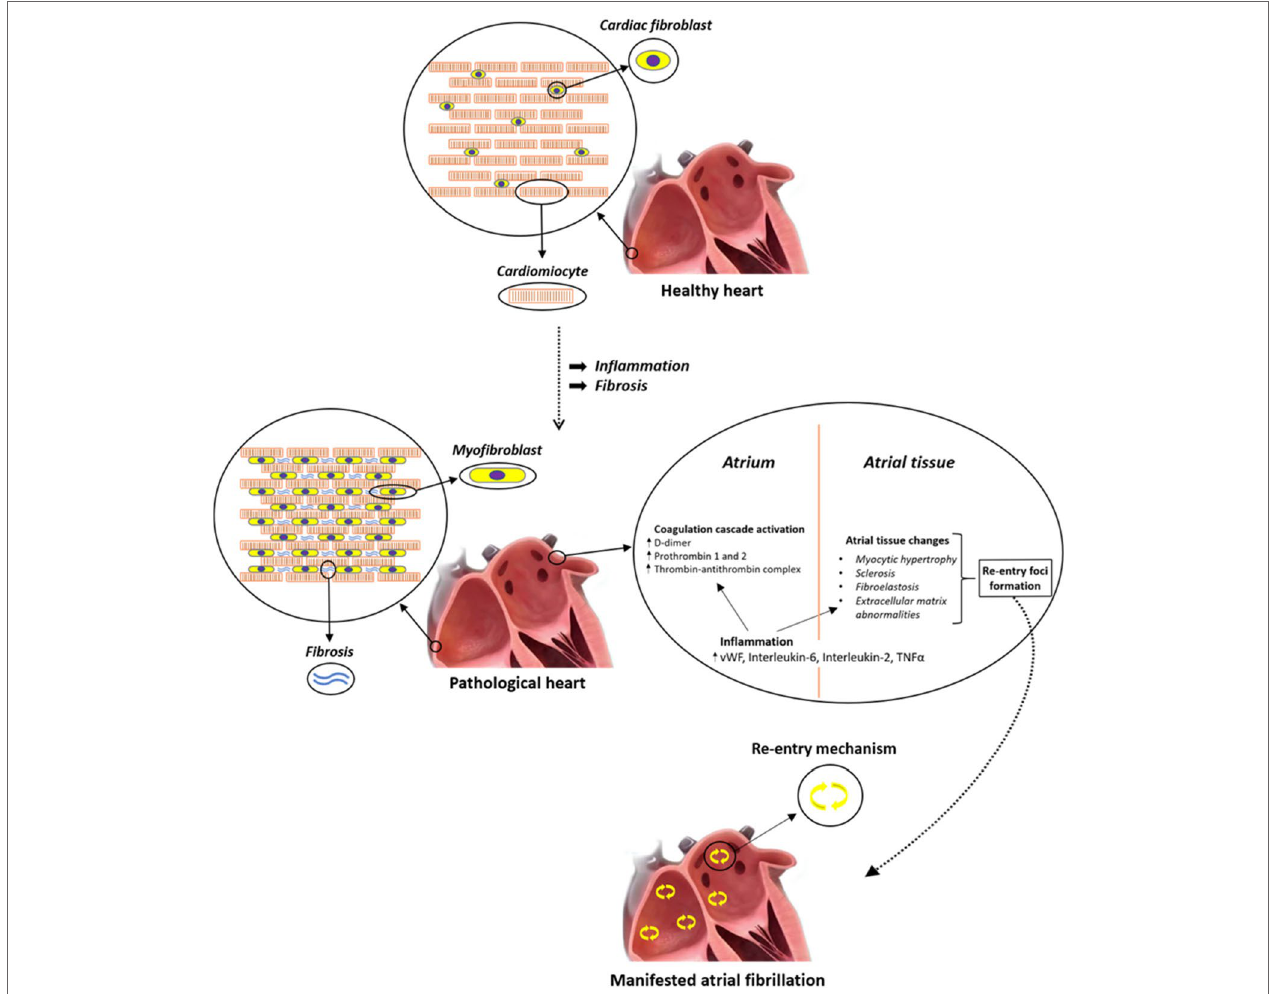
FIGURe 1 | Systemic inflammation correlates with an increased risk of atrial fibrillation (AF) and thrombogenesis. Different inflammatory mediators, such as interleukin (IL)-2 and tumor necrosis factor alpha (TNFα), affect calcium handling and cause arrhythmogenic changes in atrial cardiomyocytes. In particular, altered TNFα-mediated Ca2+ handling could lead to arrhythmias due to calcium waves and delayed after-depolarization, which may generate premature APs and give birth to spontaneous beats that can then perpetuate themselves through re-entry mechanism. In addition, circulating cytokines can also stimulate NF-κB within atrial cardiomyocytes, leading to activation of the apoptosis cascade, which in turn is responsible for cardiomyocyte death and fibrous